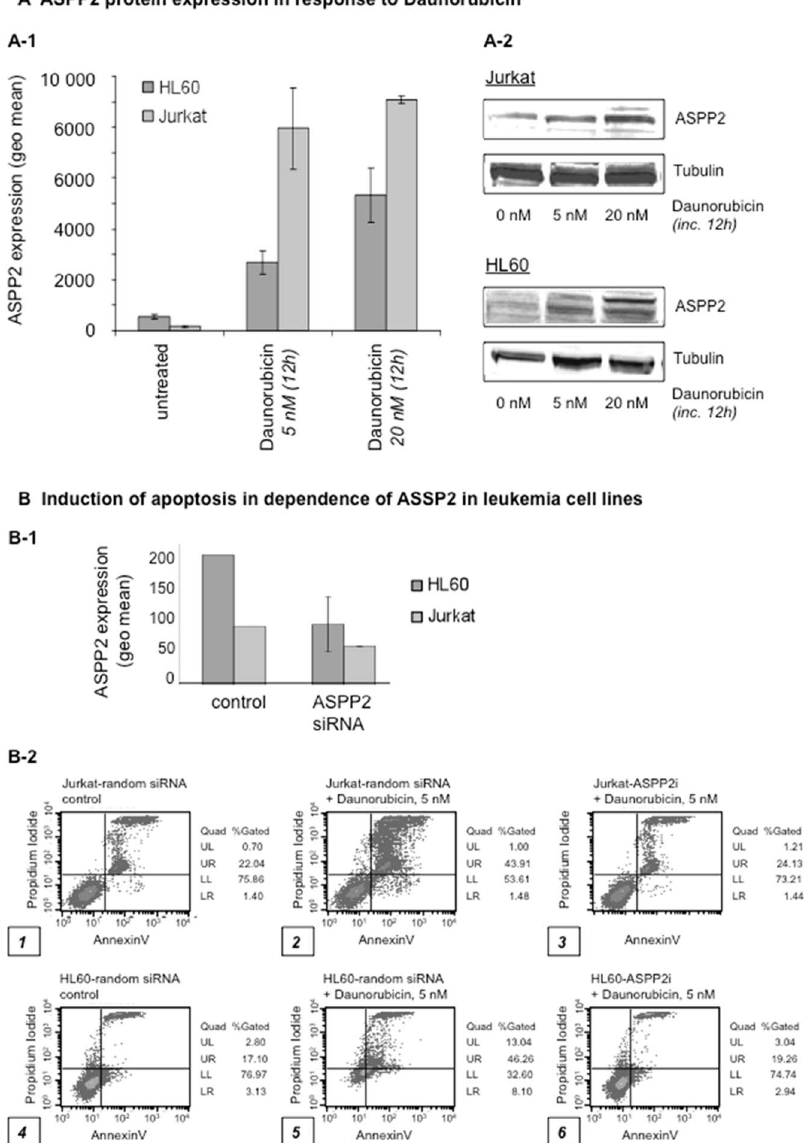
Figure 2. ASPP2 is induced upon anthracycline exposure to promote apoptosis. (A) Intracellular ASPP2 protein expression levels increase upon daunorubicin treatment in a dose-dependent manner in the acute myeloid leukemia HL60 cell line and the T-lymphoblastic leukemia Jurkat cell line. A flow cytometry based assay is shown (A-1) which is confirmed by a Western immunoblot (A-2). (B) Lipofection of Jurkat and HL60 leukemia cell lines with specific ASPP2 siRNA or random siRNA as negative controls was performed. Cells were treated with daunorubicin (5 nM) for 48 hours and induction of apoptosis was measured using an Annexin V-based assay and flow cytometry.